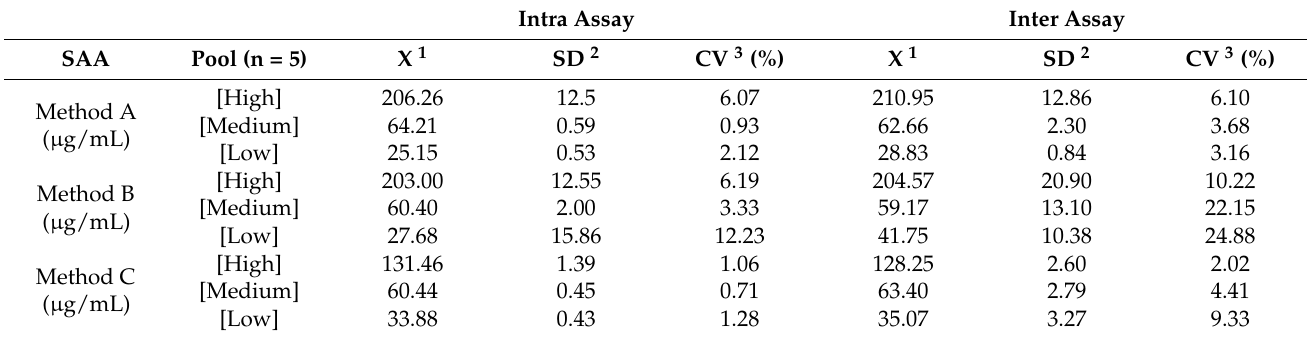
Table 1. Intra-assay and inter-assay repeatability of the assays for detection of a high (>100 µ g/mL), medium ( ≈ 50 µ g/mL) and low ( ≈ 25 µ g/mL) concentrations of feline serum amyloid A protein (SAA). The test assays used were Fujifilm (method A), Eurolyser Diagnostica (method B) and Eiken (method C). Intra Assay Inter Assay